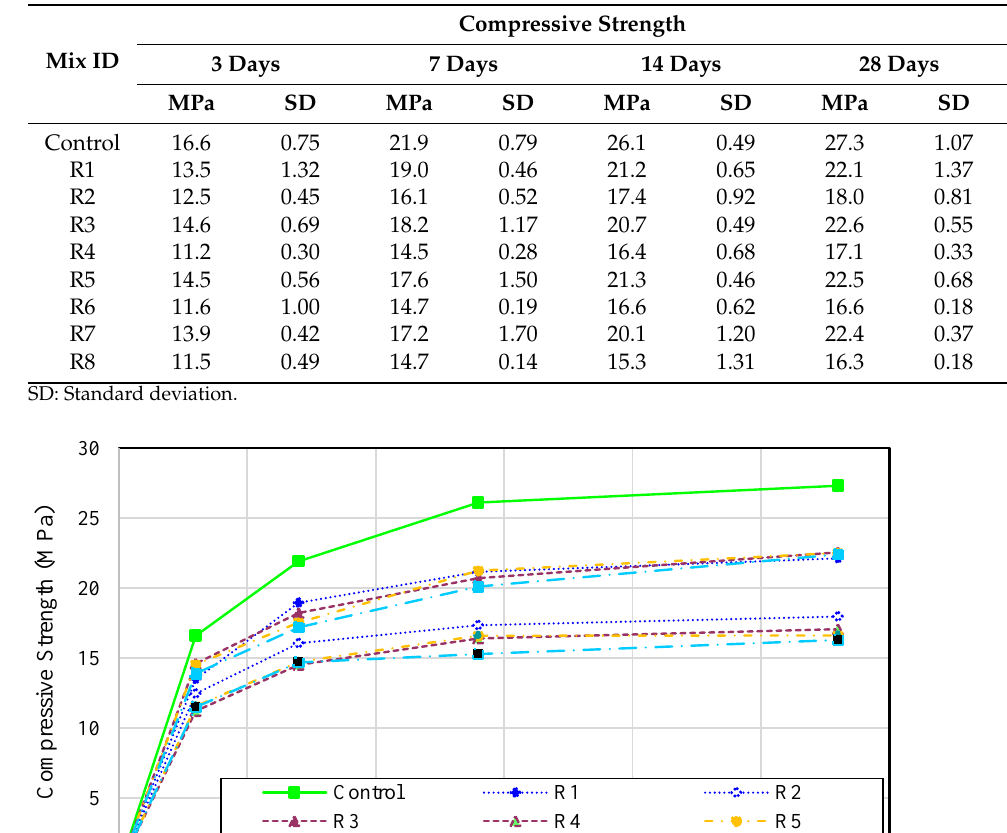
Table 3. Compressive strength test results.